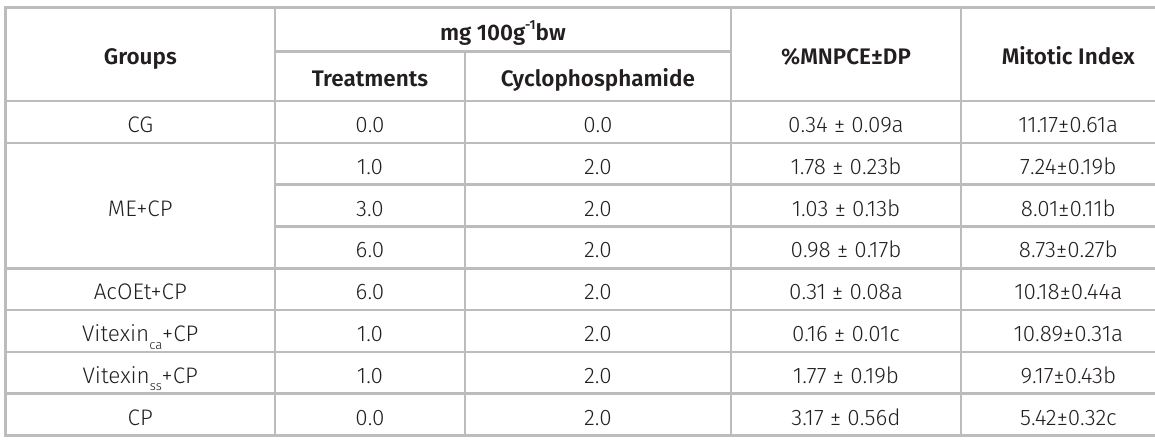
Table II. Mitotic Index and Micronucleated polychromatic erythrocyte (MNPCE) frequency in Swiss albino mice (n=5) treated with different concentrations of methanolic extract (ME) (1, 3 and 6 mg 100g -1 bw) and fraction (Ethyl